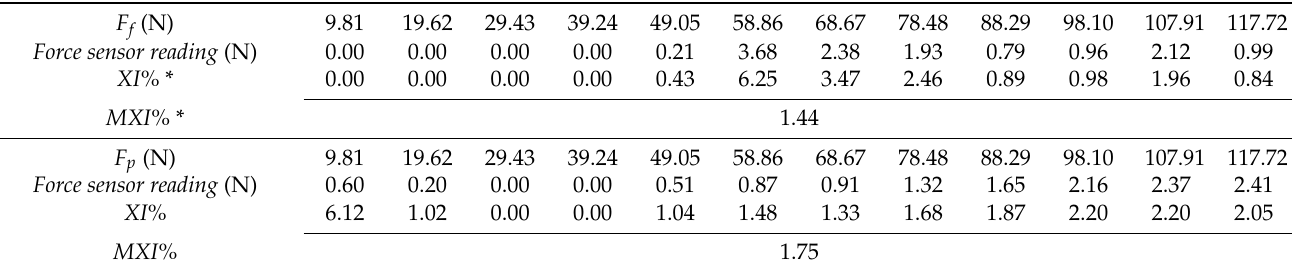
Table 5. The results of the cross-interference test.